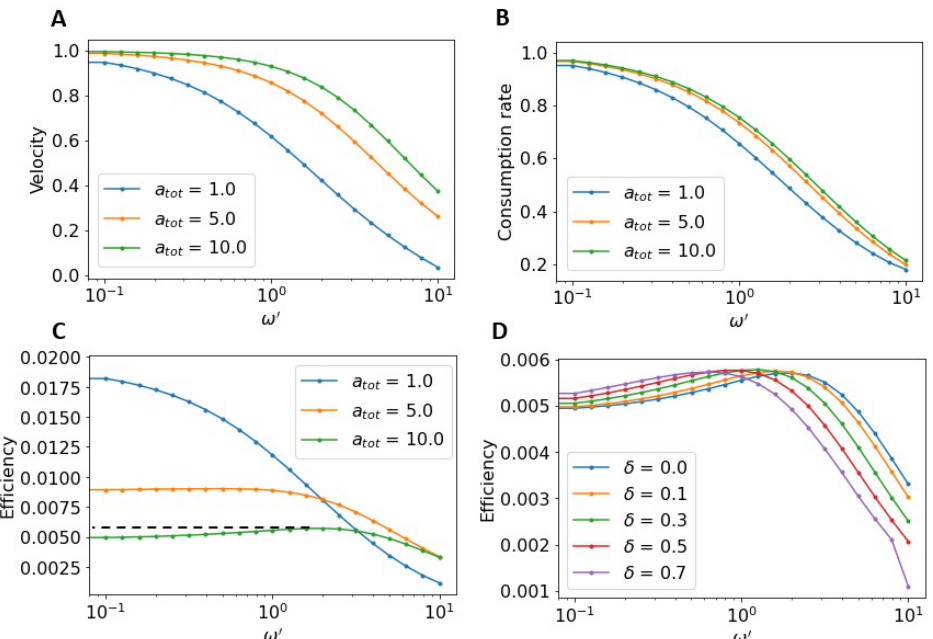
Figure 6. Effects of complex unbinding on efficiency. ( A ) The normalized velocity as a function of ω (cid:48) . Velocities normalized by the maximum velocity for a given a tot . ( B ) The normalized consumption rate as a function of ω (cid:48) . (In A,B some curves approach 1 slowly). ( C ) The absolute efficiency as a function of ω (cid:48) at different a tot . At lower substrate concentrations the maximal efficiency occurs when there is no complex unbinding (i.e., ω (cid:48) = 0). At higher substrate concentration (i.e., a tot = 10) the optimal efficiency occurs at a non-zero unbinding rate. For calculations in ( A – C ), δ = 0. ( D ) The efficiency as a function of ω (cid:48) at different δ . For larger δ the optimal ω (cid:48) is greater. δ makes no significant difference in the global maximal efficiency of the motor. For calculations in D, a tot = 10. In all of the above = K = 0.01, ∆ g = calculations, ν (cid:48) = 1, k (cid:48) of f